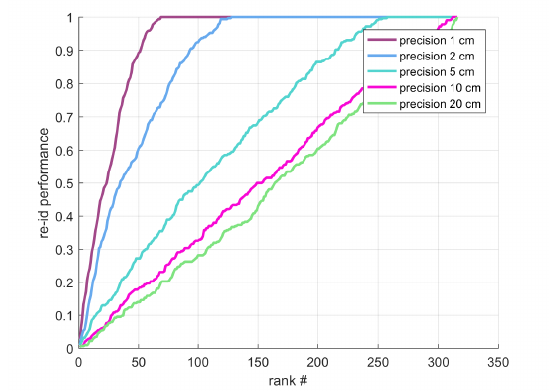
Figure 13. CMC curve for the simulation of German